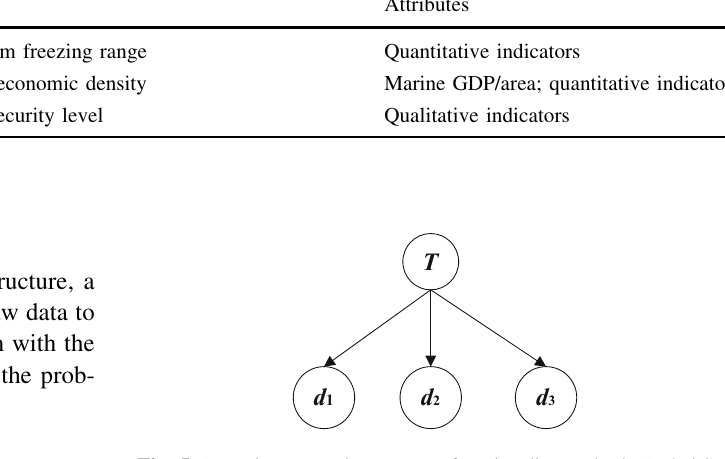
Table 4 Assessment indicator system to measure potential sea ice hazard risk in the Bohai Sea Assessment target